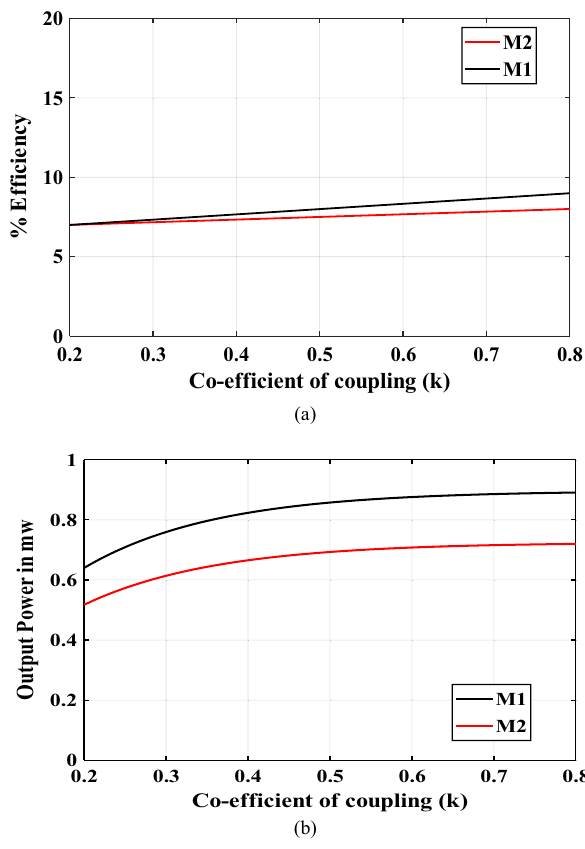
Figure 6: SP/PP topology: ( a ) change in e ffi ciency with respect to the coe ffi cient of coupling and ( b ) change in output power with respect to the coe ffi cient of coupling.